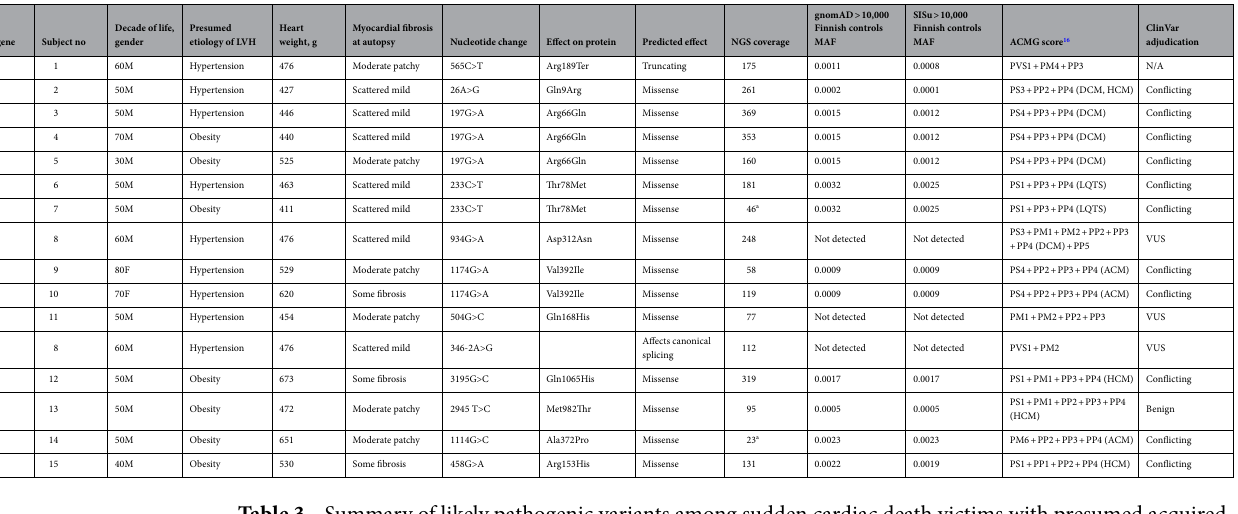
Table 3. Summary of likely pathogenic variants among sudden cardiac death victims with presumed acquired cardiac disease. ACMG American college of molecular genetics, ACM arrhythmogenic cardiomyopathy, DCM dilated cardiomyopathy, HCM hypertrophic cardiomyopathy, LQTS long QT syndrome, LVH left ventricle hypertrophy, MAF minor allele frequency, NGS next generation sequencing, VUS variant of uncertain significance. a Verified by Sanger